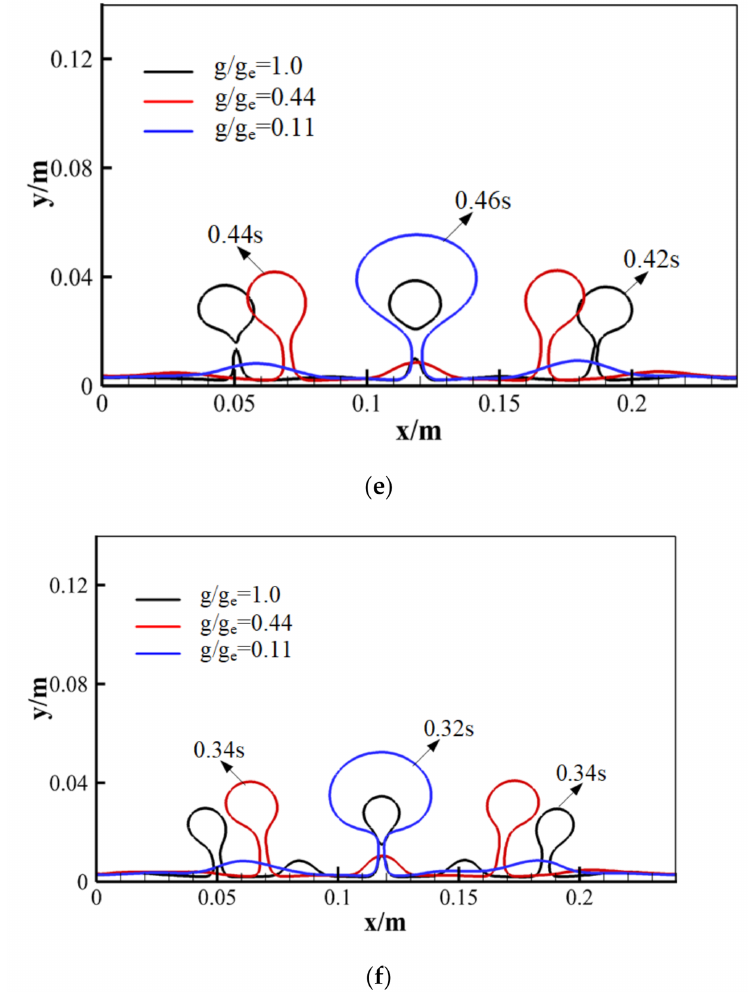
Figure 8. Effect of the magnetic field intensity on the departure of the first set of bubbles at dif- ferent gravity levels. ( a ) H 0 = 0 kA/m, ( b ) H 0 = 5 kA/m, ( c ) H 0 = 10 kA/m, ( d ) H 0 = 15 kA/m,